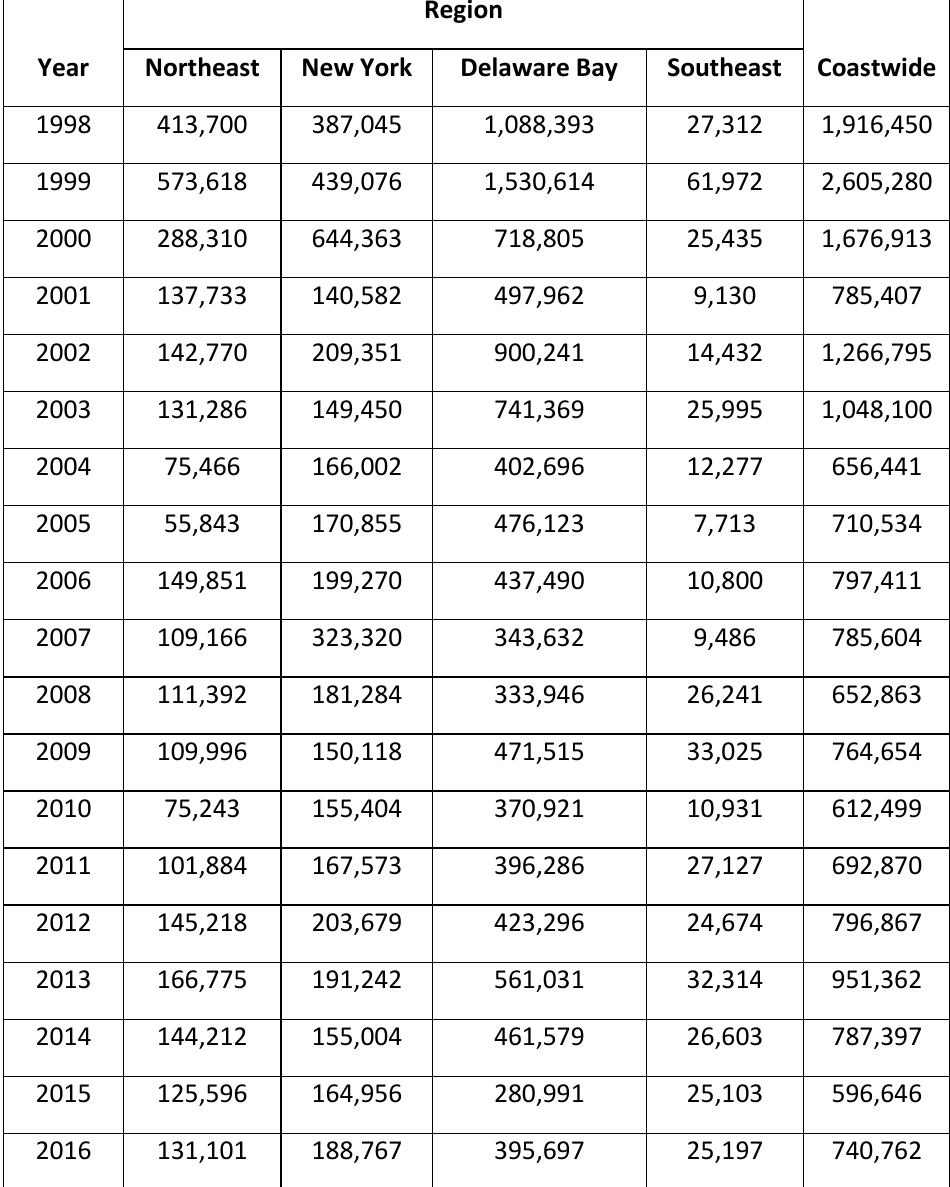
Table 13. Commercial bait landings in numbers of horseshoe crabs by region, 1998-2016. The four regions are the Northeast (Maine, Massachusetts, Rhode Island), New